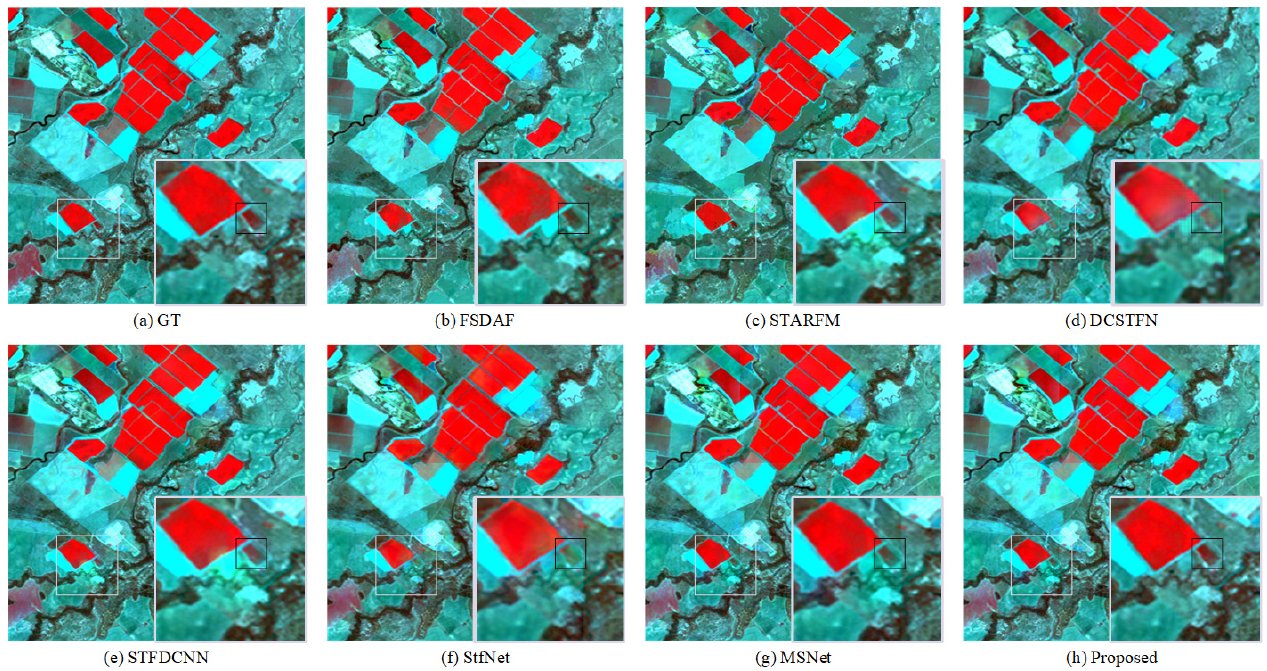
Figure 9. Comprehensive prediction results for the target Landsat image (14 February 2005) in LGC dataset. Comparison methods include FSDAF [11], STARFM [8], DCSTFN [23], STFDCNN [18], StfNet [19], and MSNet [36], which are represented by ( b – g ) in the figure respectively. ( a ) represents the ground truth (GT), and ( h ) represents the proposed method.